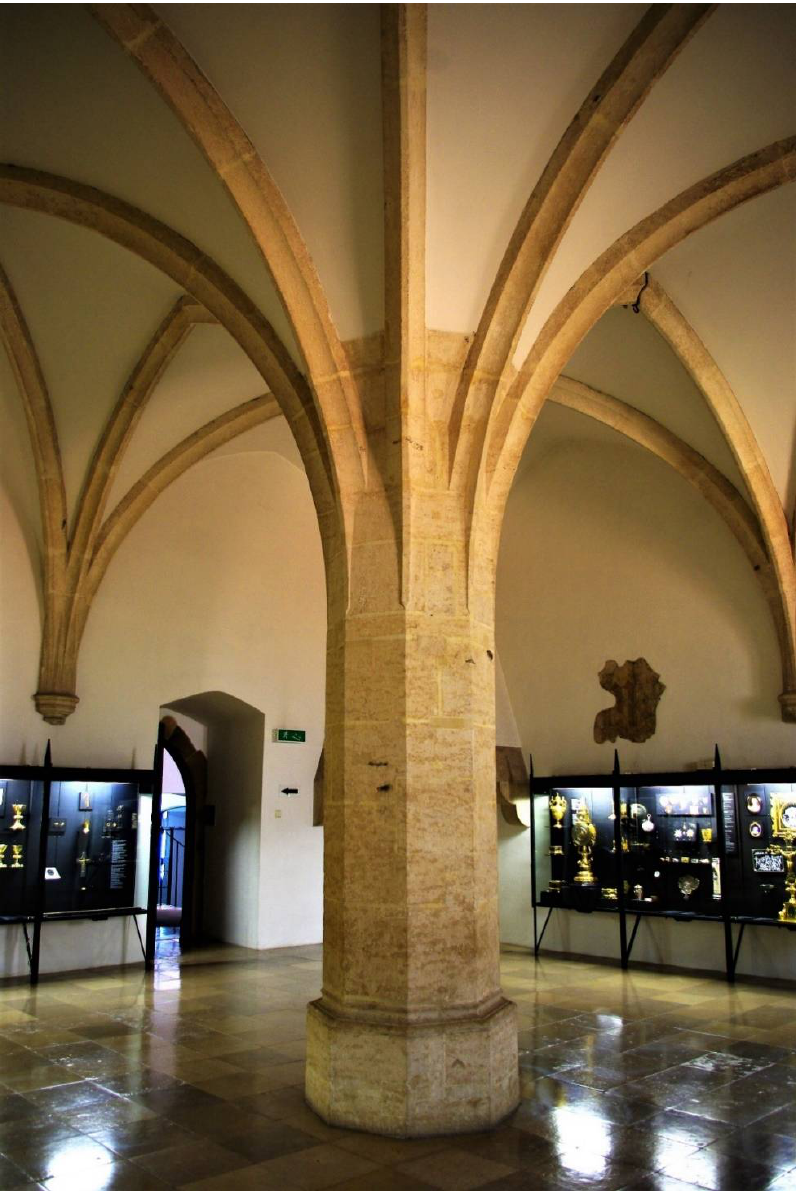
Figure 10. Kraków, Wawel castle, Ground floor of the Hen’s Foot Tower (now called the Casimir Figure 10. Krak ó w, Wawel castle, Ground floor of the Hen’s Foot Tower (now called the Casimir Hall). General view. Photo by Tomasz Ratajczak, the author’s own work. Hall). General view. Photo by Tomasz Ratajczak, the author’s own